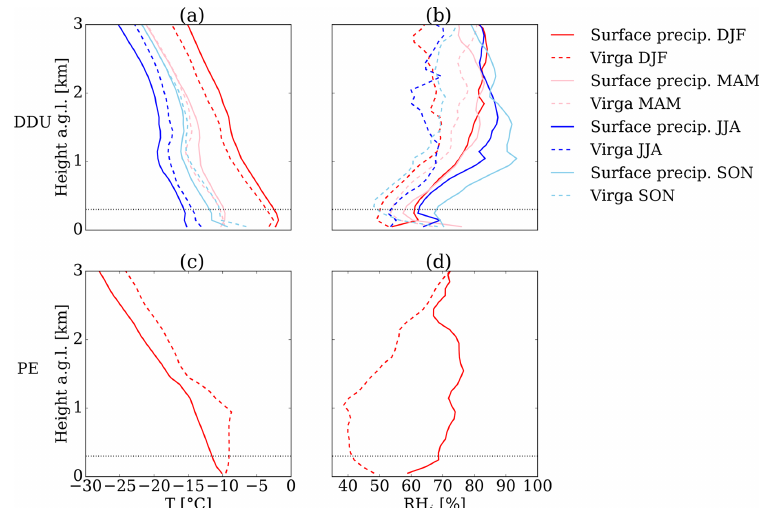
Figure 6. Average vertical profiles of air temperature T (a, c) and relative humidity with respect to ice RH i (b, d) during simultaneous time of radio sounding and profiles of precipitation observed with MRR at DDU (a, b) and PE (c, d) . Red, pink, blue, and sky blue lines represent the summer (DJF), autumn (MAM), winter (JJA), and spring (SON), respectively, and solid lines correspond to surface precipitation while dashed lines are virga events. Horizontal dotted lines correspond to the height of the lowest available MRR bin (300m). Table 1. Percentage of surface precipitation and ice virga with respect to the total number of vertical precipitation profiles during all data periods and each season at DDU and PE. Site Precipitation type All seasons DJF MAM